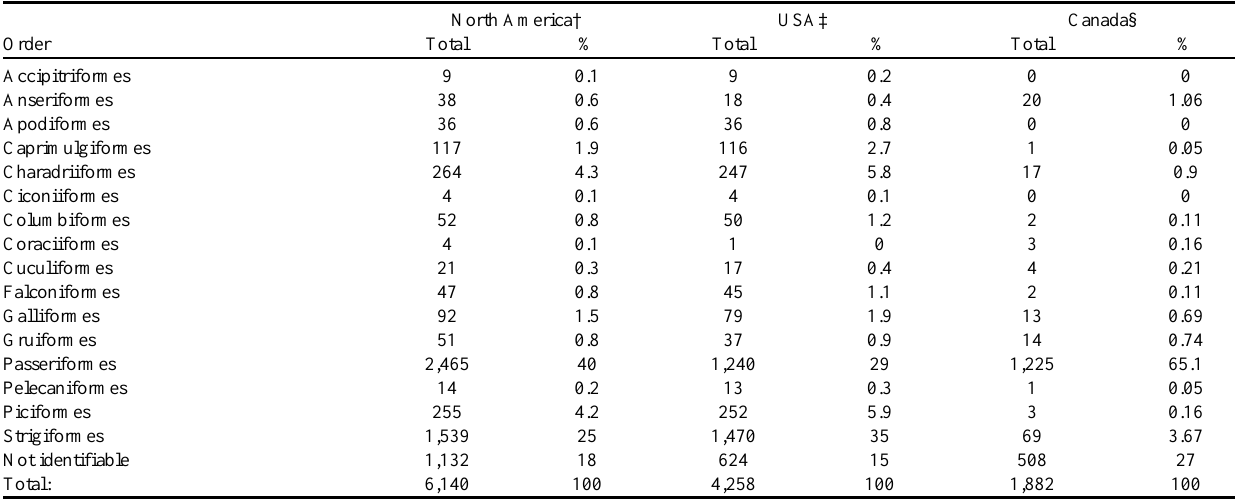
Table 4 . Proportions of avian orders and total sample size of birds reported, as compiled from North American reports of avian casualties attributed to collisions with vehicles. North America† USA‡ Canada§ Order Total % Total % Total % Accipitriformes